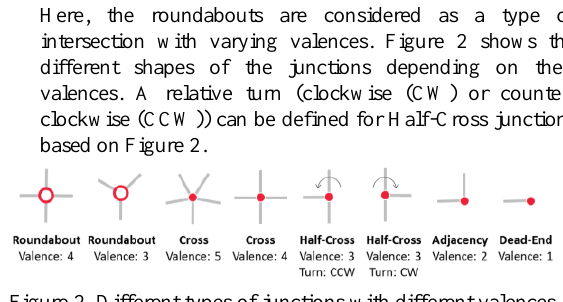
Figure 2. Different types of junctions with different valences, turns and